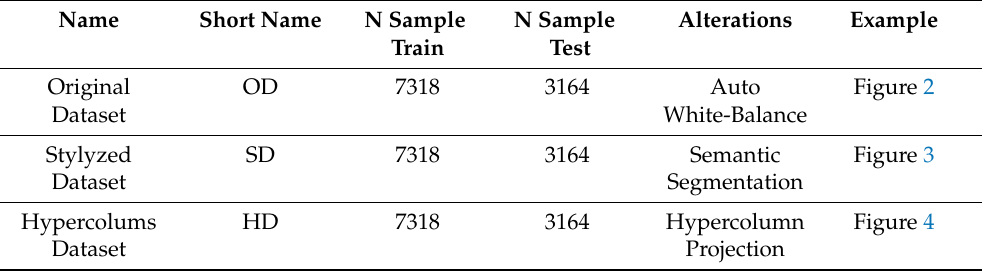
Figure 4. Example of an image alterated for the Stylized Dataset. Table 1. Datasets’